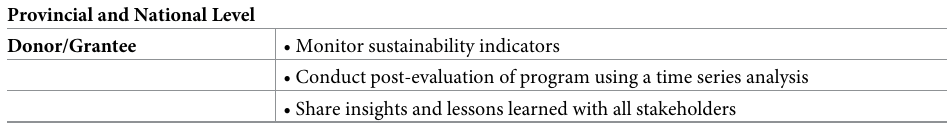
Table 8. Post transition (3–5 years after the end of the